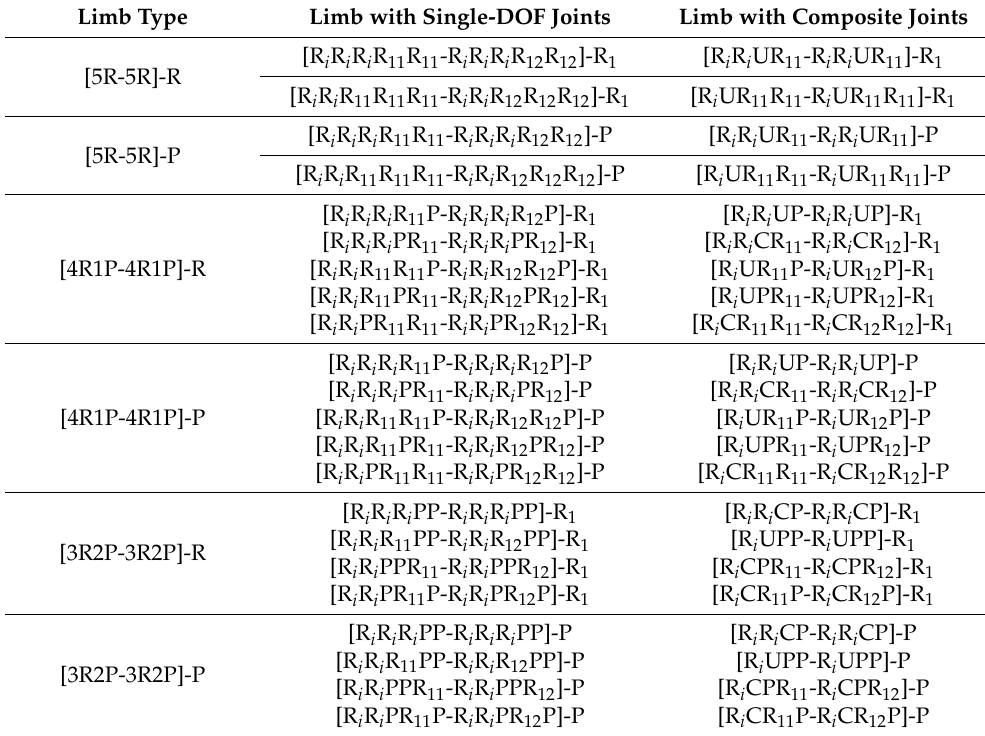
Table 1. The first class of F-hybrid limbs.